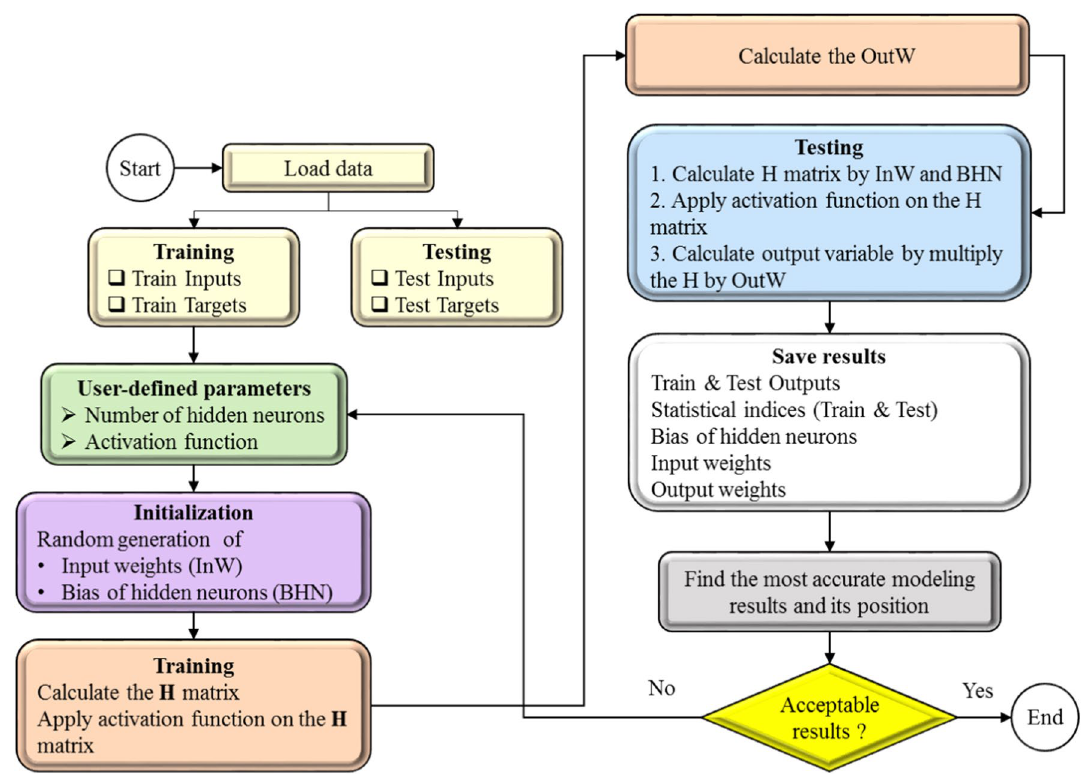
Fig. 3 Flowchart of the ORELM model (Zhang and Luo